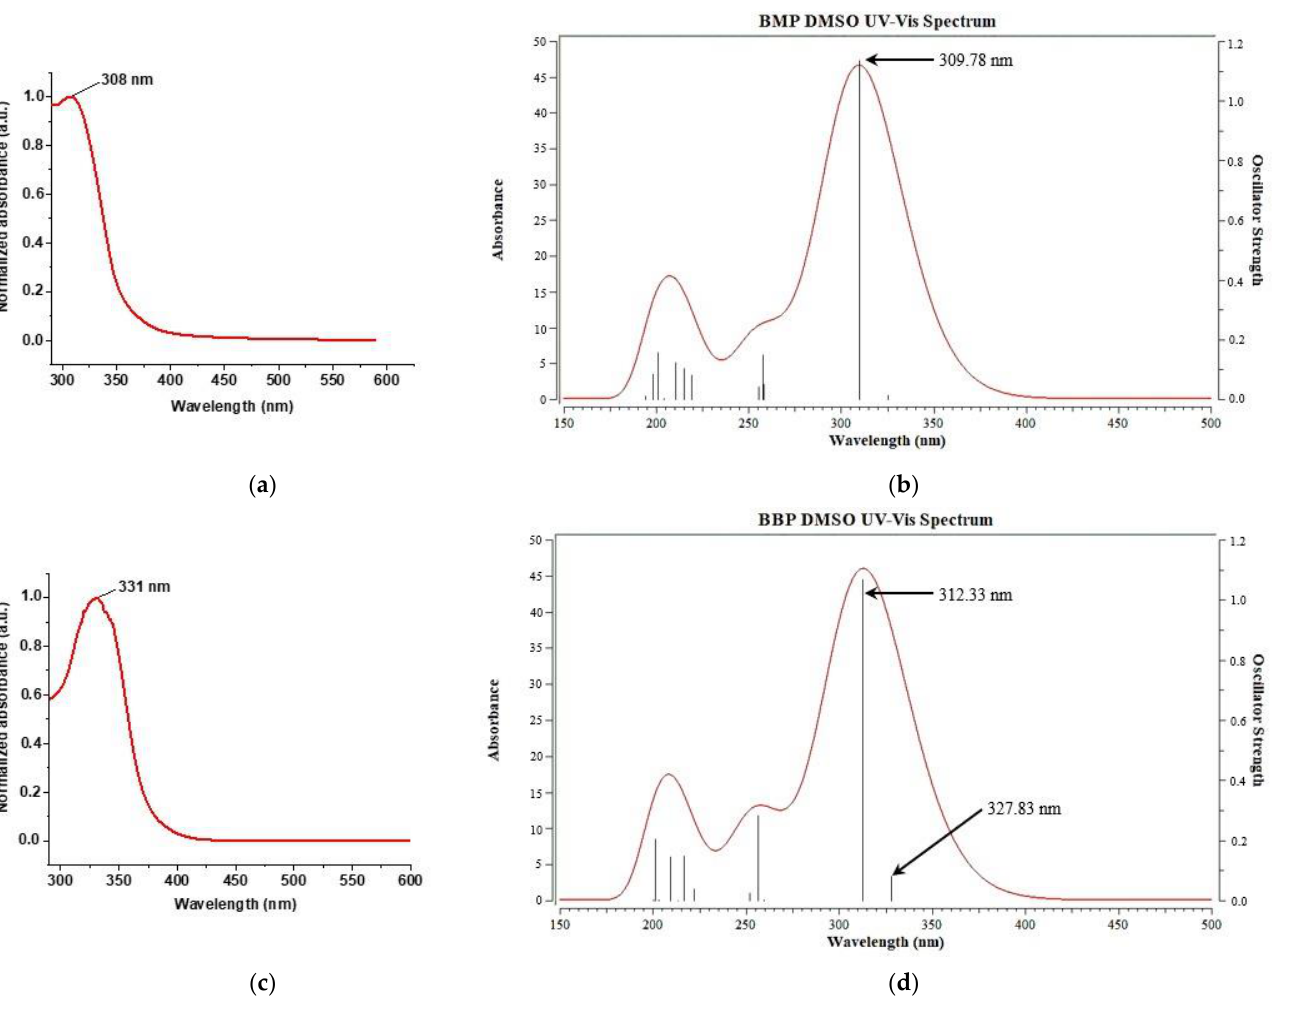
Figure 13. UV-vis spectra ( a , b ) experimental and ( c , d ) theoretical of BMP, and BBP chalcones in DMSO.